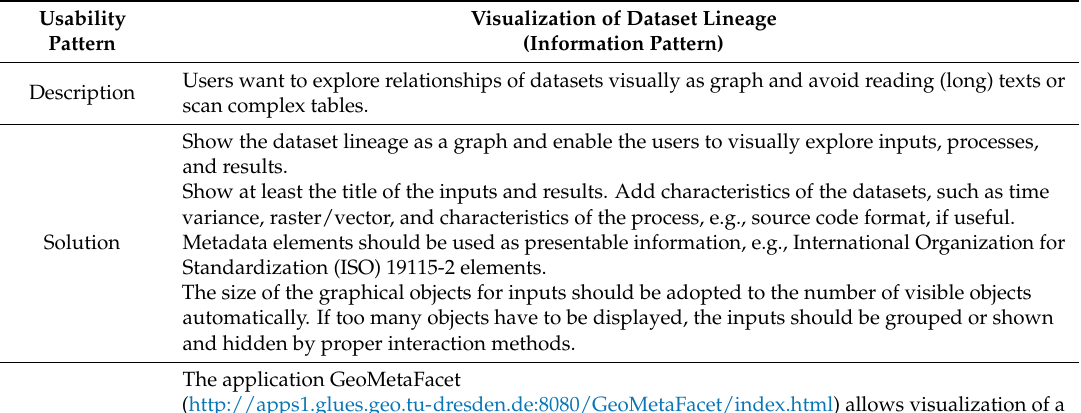
Table 6. Usability pattern Visualization of dataset .